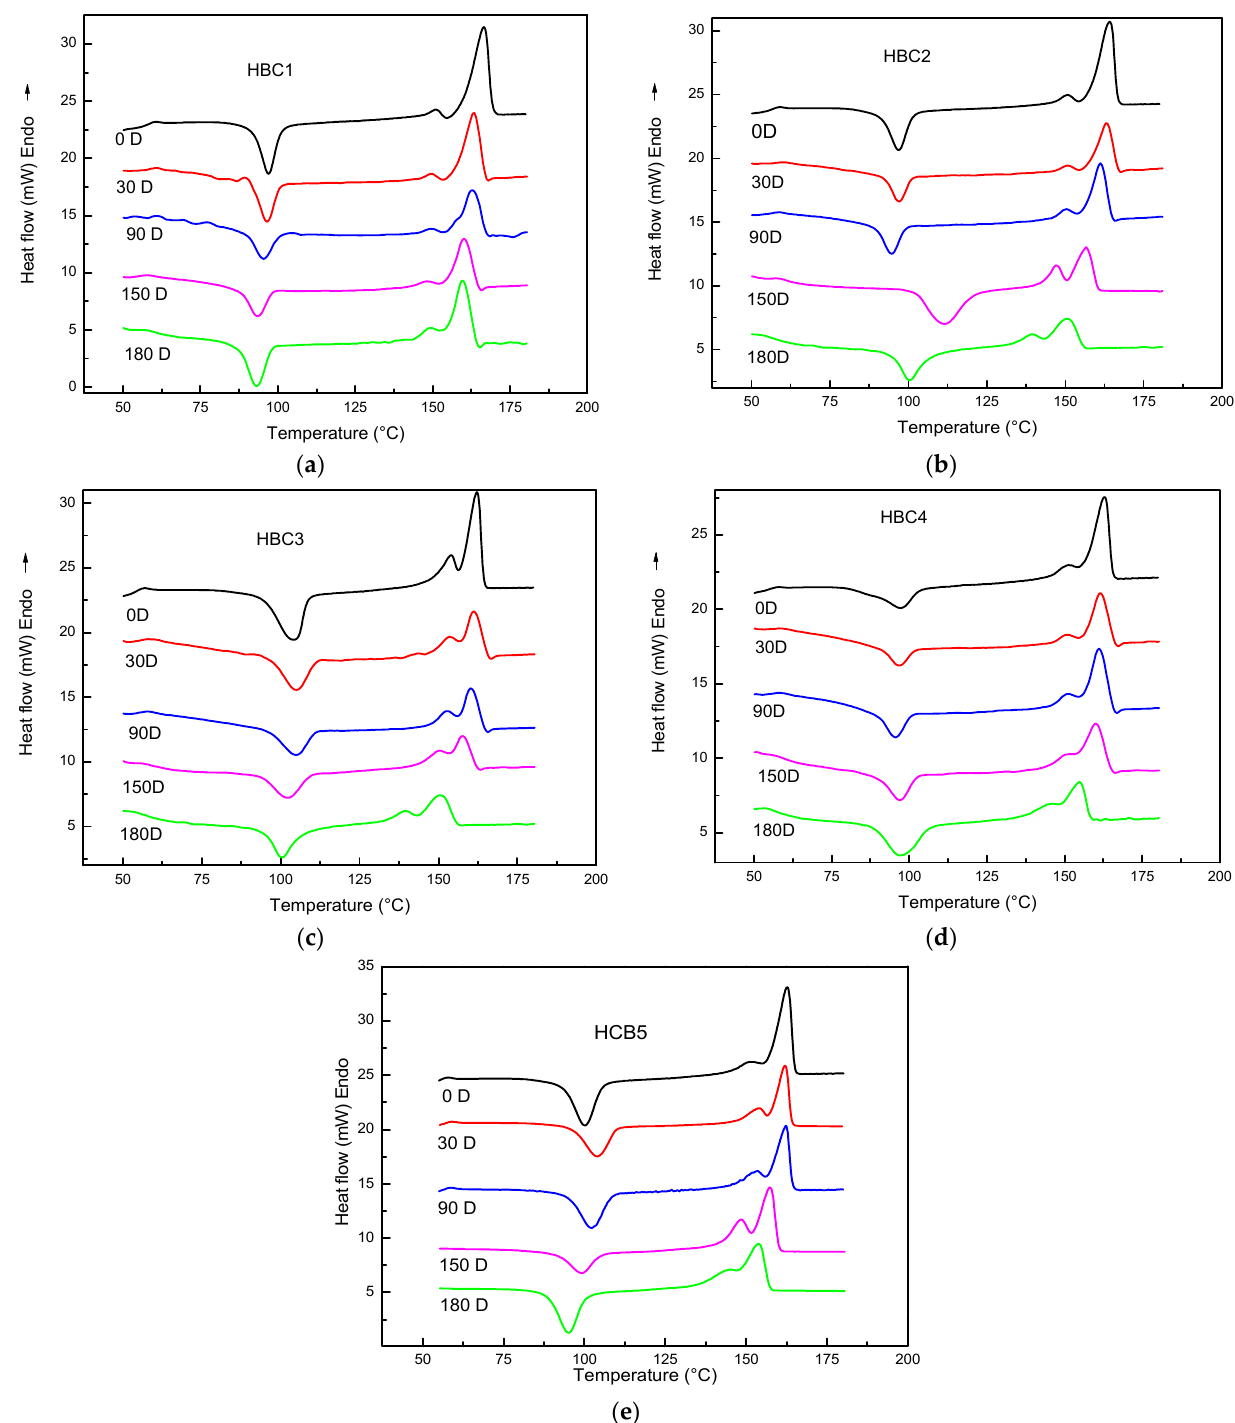
Figure 7. HBC thermograms for different composting days in samples: ( a ) HBC1; ( b ) HBC2; ( c ) HBC3; ( d ) HBC4; ( e ) HBC5.